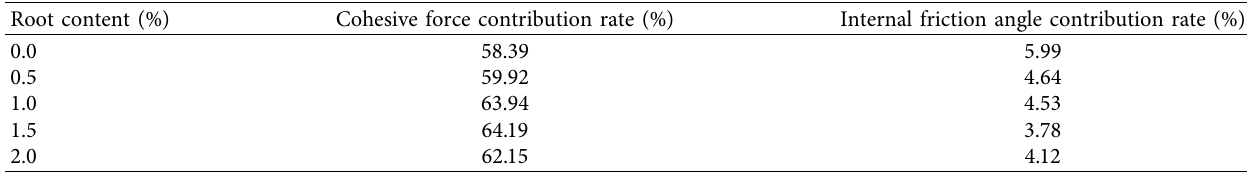
Table 4: MICP contribution